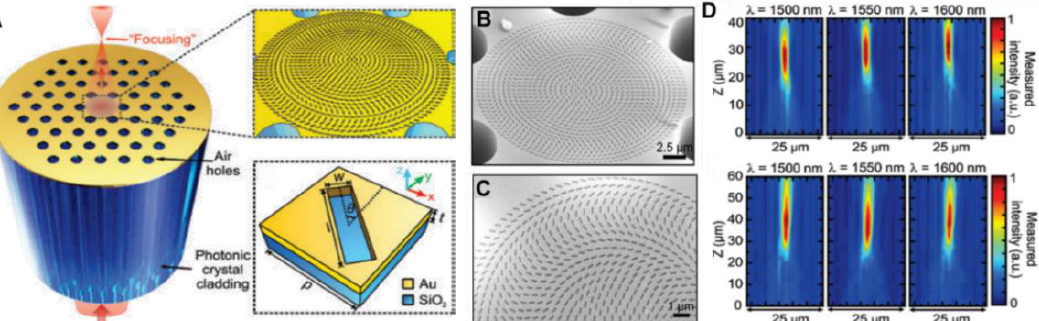
Figure 2. ( a ) Schematic of in-fiber metalens based on LAM-PCF. ( b,c ) SEM images of the fabricated PCF metalens with NA = 0.37. ( d ) Measured intensity distributions of PCF metalenses with NA = 0.37 and NA = 0.23. Reprinted with permission from Ref. [43] . Copyright 2019, De Gruyter.